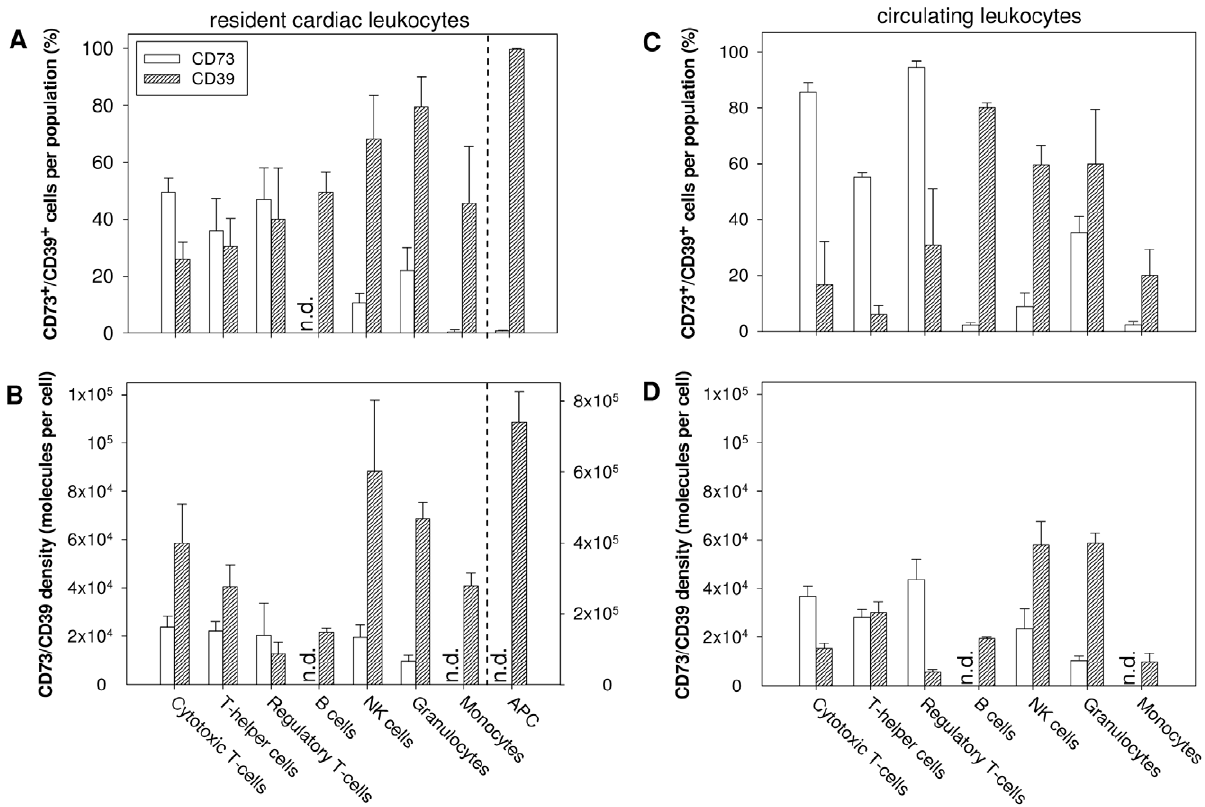
Figure 3. Abundance of CD73 and CD39 on leukocytes in blood and heart under basal conditions. A : CD73 + and CD39 + cells per leukocyte population in cardiac tissue. B : CD73/CD39 surface density on CD73 + /CD39 + cells per leukocyte population in cardiac tissue. C : CD73 + and CD39 + cells per leukocyte population in blood. D : CD73/CD39 surface density on CD73 + /CD39 + cells per leukocyte population in blood. Only positive gated CD73 or CD39 cells (Fig. 3A, 3C) were considered for the calculation of antigen density. Values are means 6 SD of n=5 experiments. n.d.=not detectable.